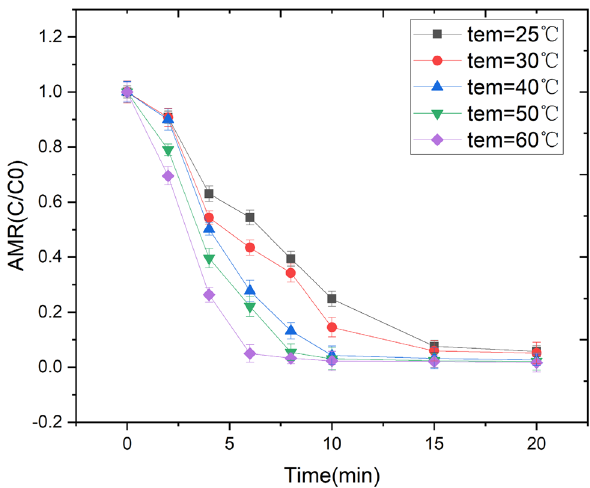
Fig. 4 Effect of temperature on AMR degradation in persulfate– ZVI system. [AMR]